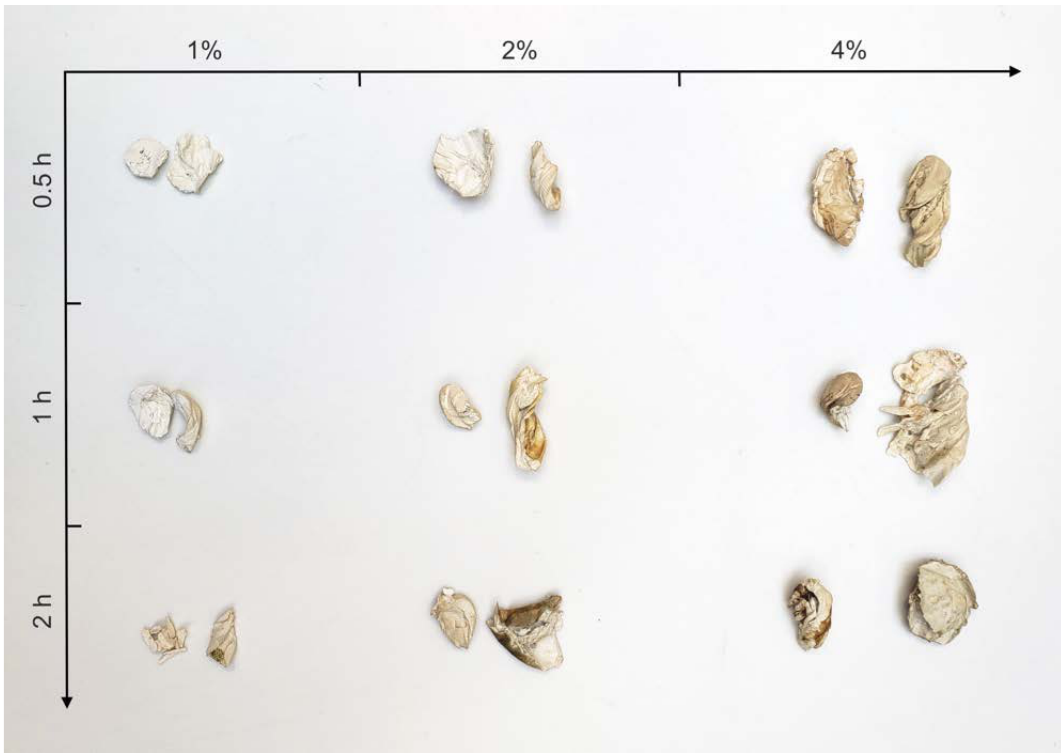
Figure 3. Comparison between the purified PHA at different experimental points.